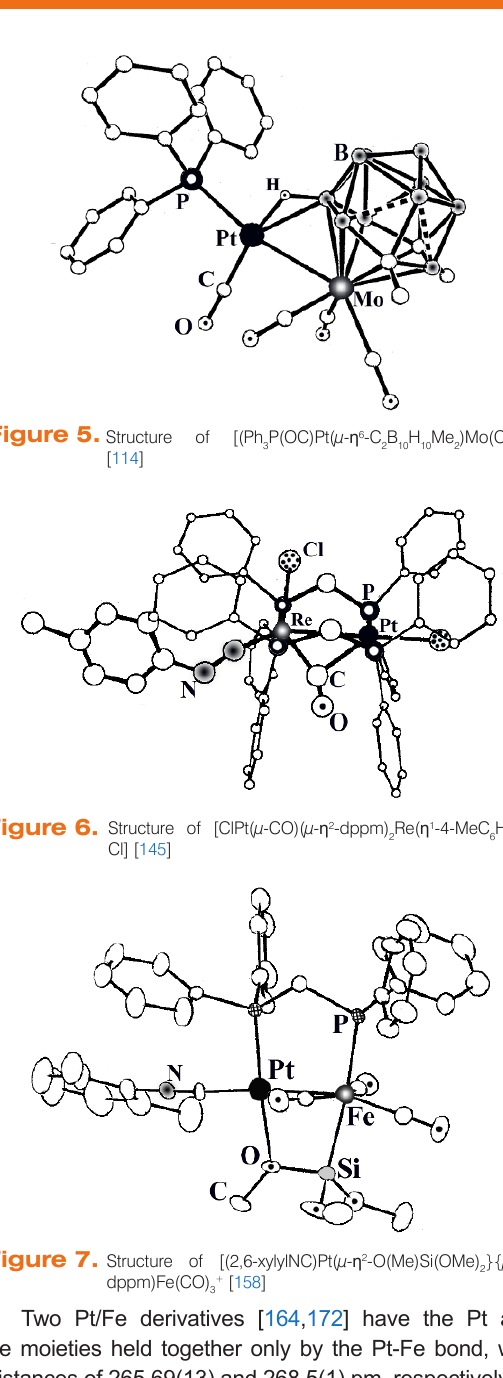
P(OC)Pt(μ- η 6 -C 3